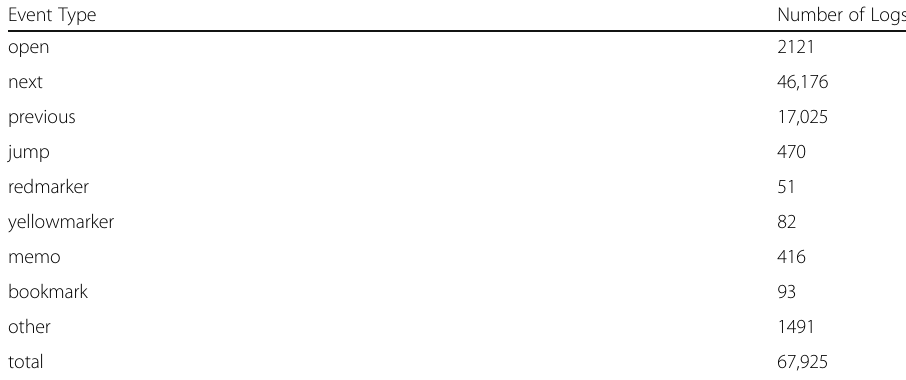
Table 1 Number of logs in each event Event